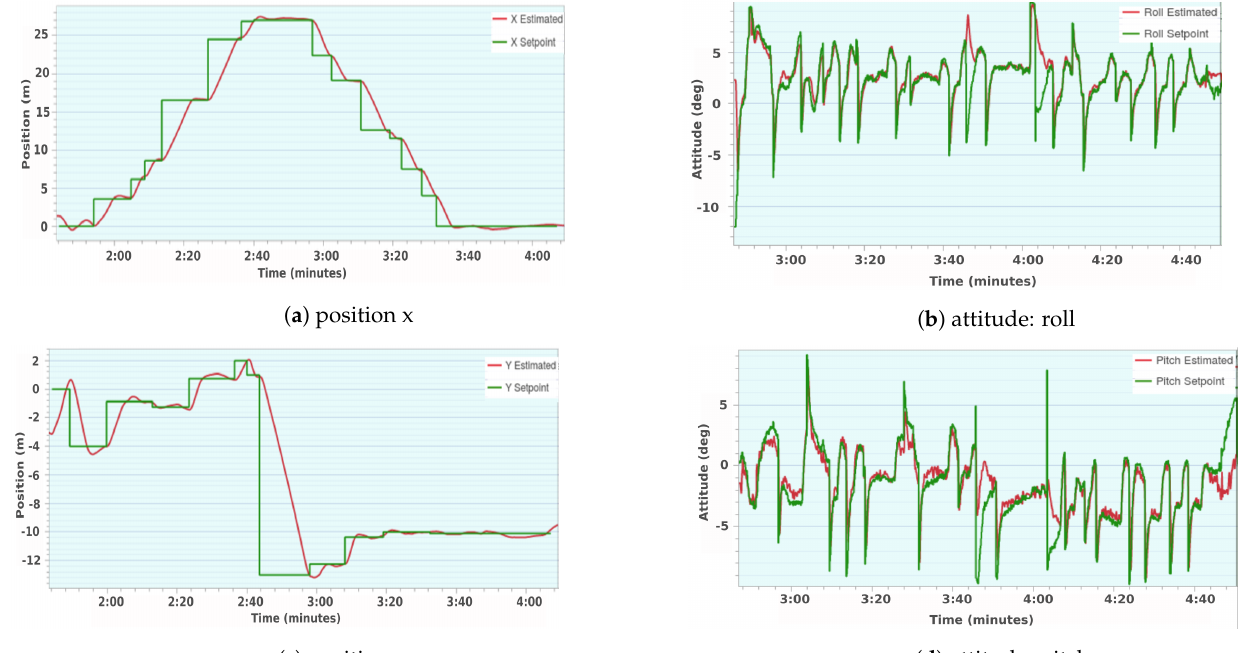
Figure 13. Real flight test for path planner efficiency